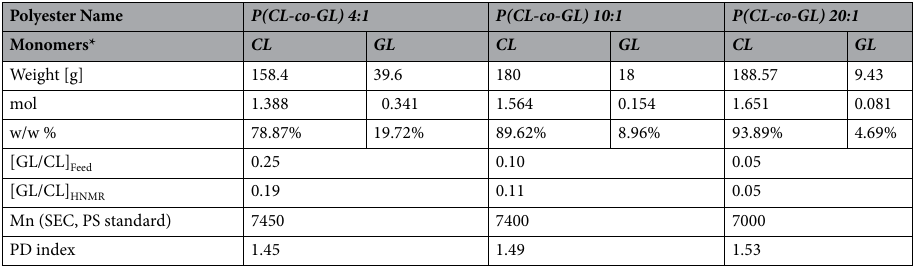
Table 1. P(CL-co-GL) triols data table. [GL/CL] HNMR i.e. the molar ratio between GL and CL for each polymer, was semi-quantitatively calculated from 1HNMR spectra of each polyester triol by integrating the areas under the peaks: 4.6 – 4.74 ppm (–O–C H 2 –COO–) of GL and 4.18 ppm (–(CH 2 ) 4 –C H 2 –OOC– CH 2 –COO–) of CL (supplementary data: Fig. S1 and Table S1). The average number molecular weight was calculated by SEC analysis, using PS standard kit for system calibration. PD index is calculated as the ratio between the average number m.wt (M n ) and the average weight m.wt (M w ). CL = ε-caprolactone, GL =